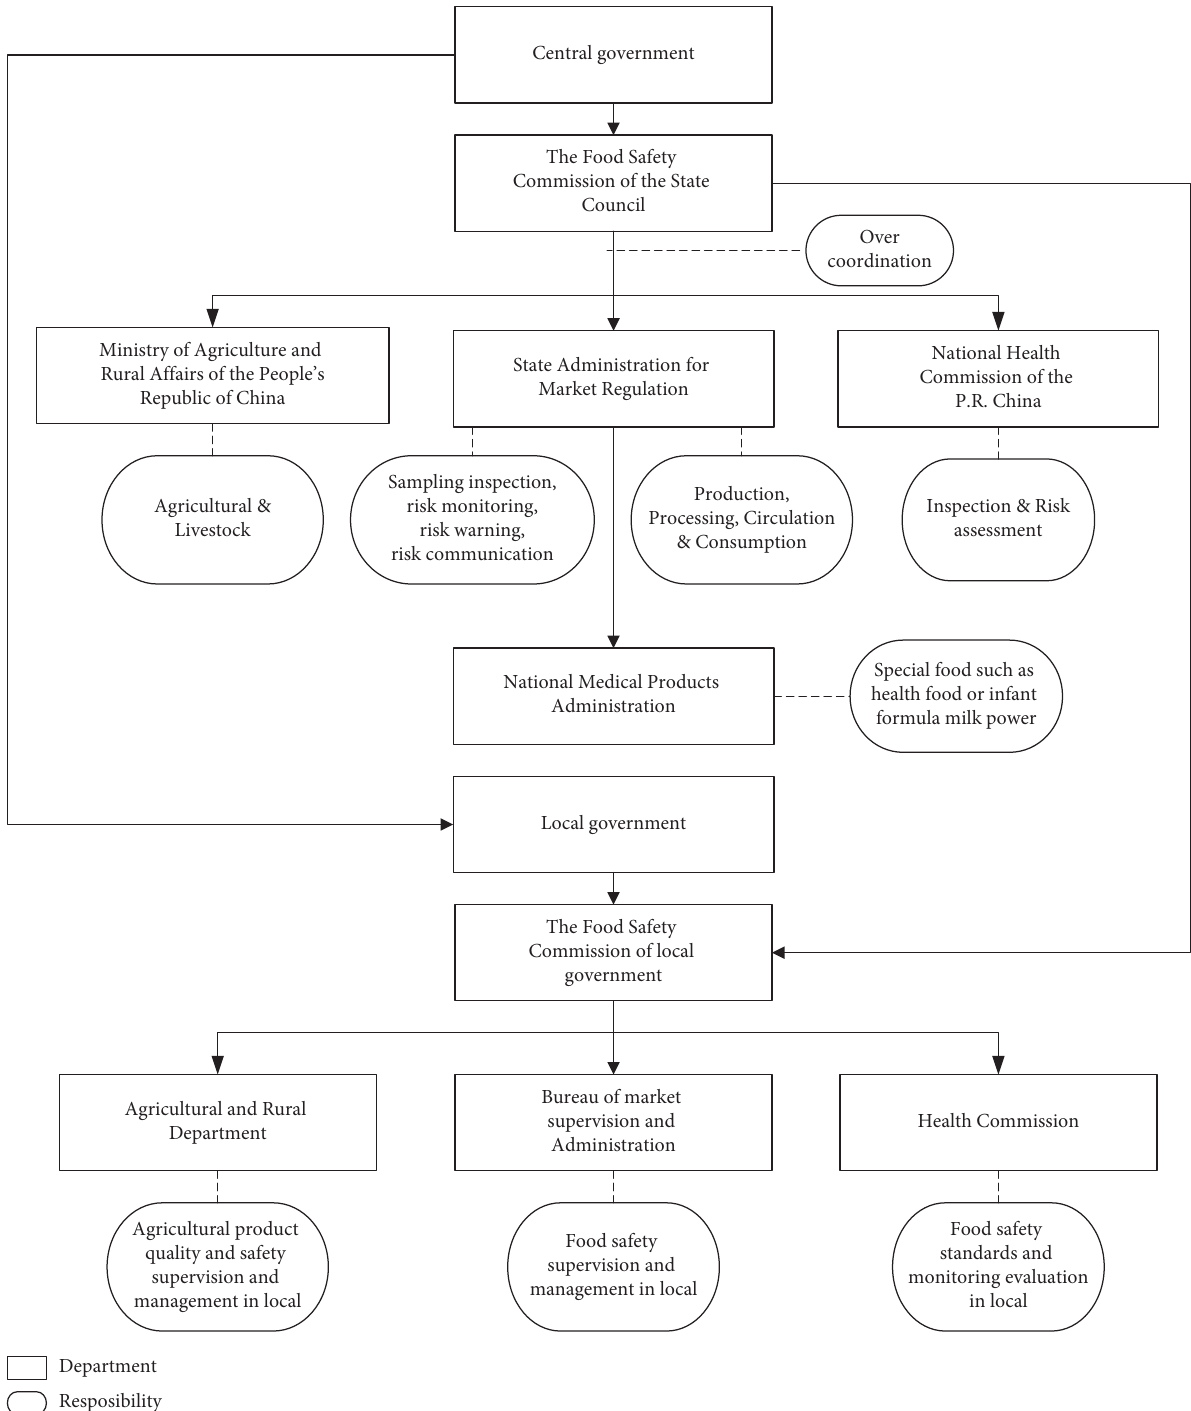
Figure 1: The current government authorities involved in food safety governance in China. Source: adapted from [13,